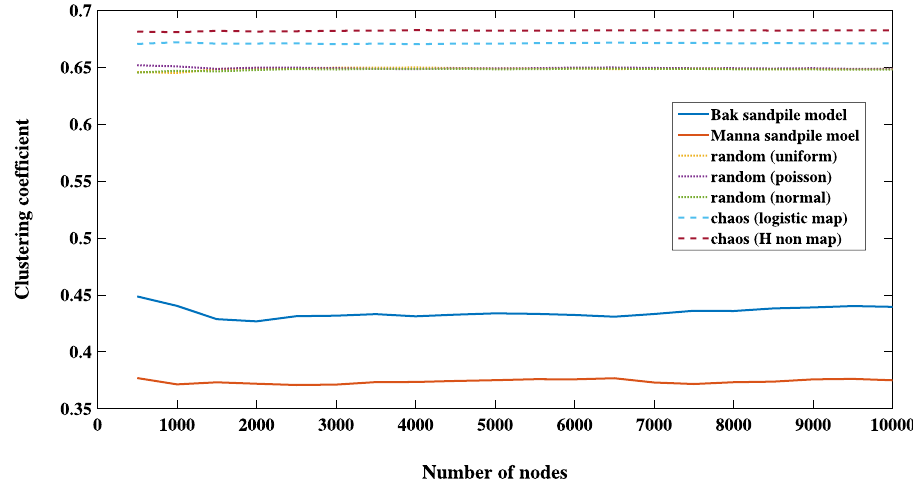
Figure 5. The average clustering coefficient for the Bak (solid blue line) and Manna (solid red line) models, several random TS (dotted colored lines), and two chaotic TS (dashed colored